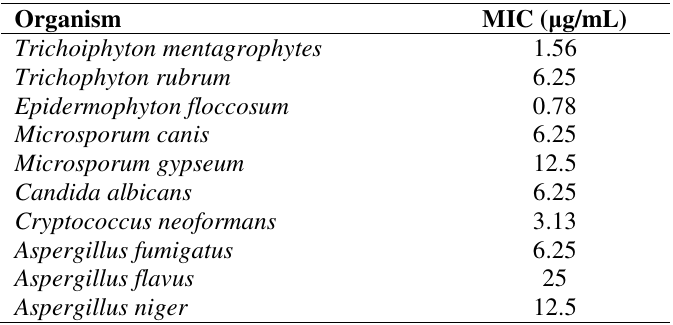
Table 9. In vitro antifungal activity of sulconazole